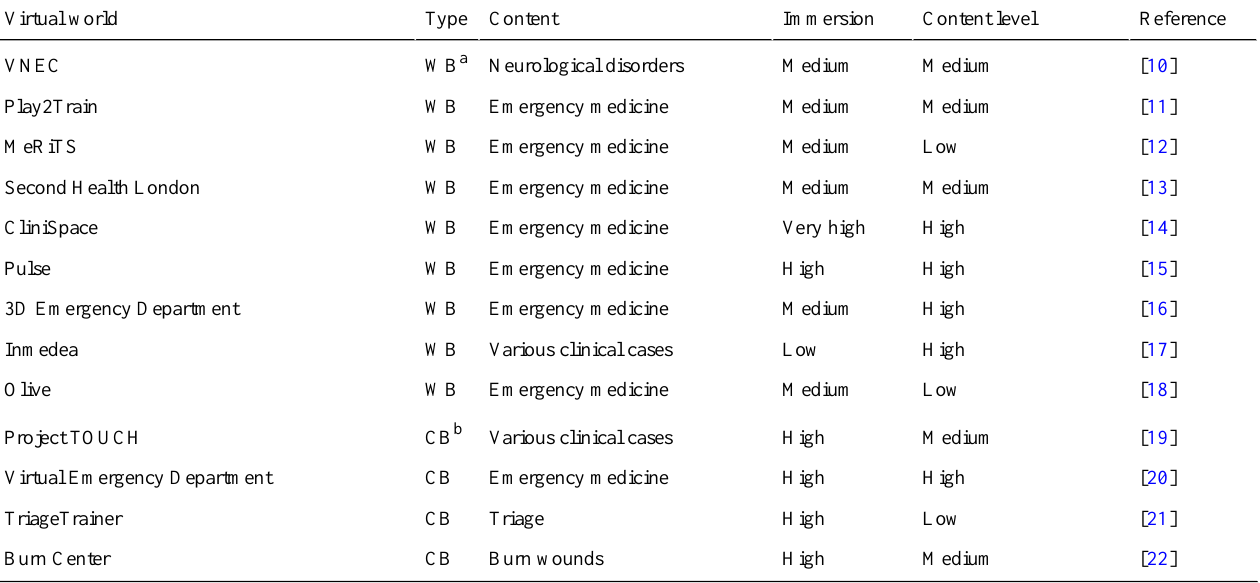
Table 1. List of available virtual patient